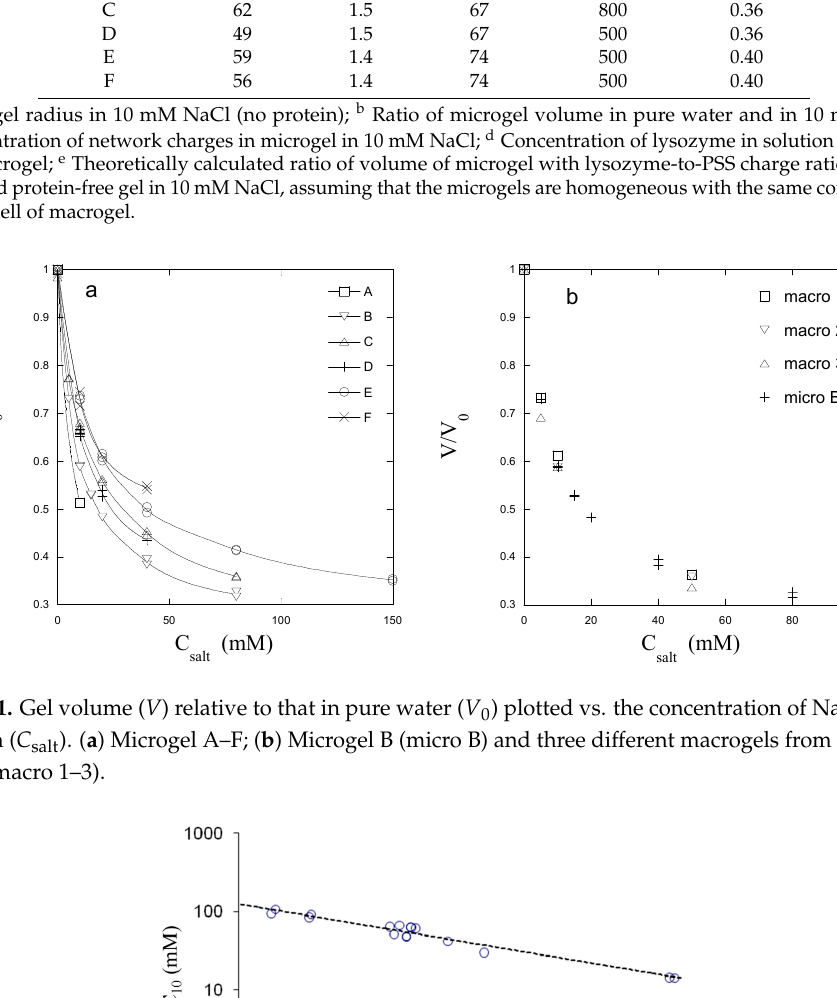
Table 1. Description of the investigated lysozyme–microgel systems.